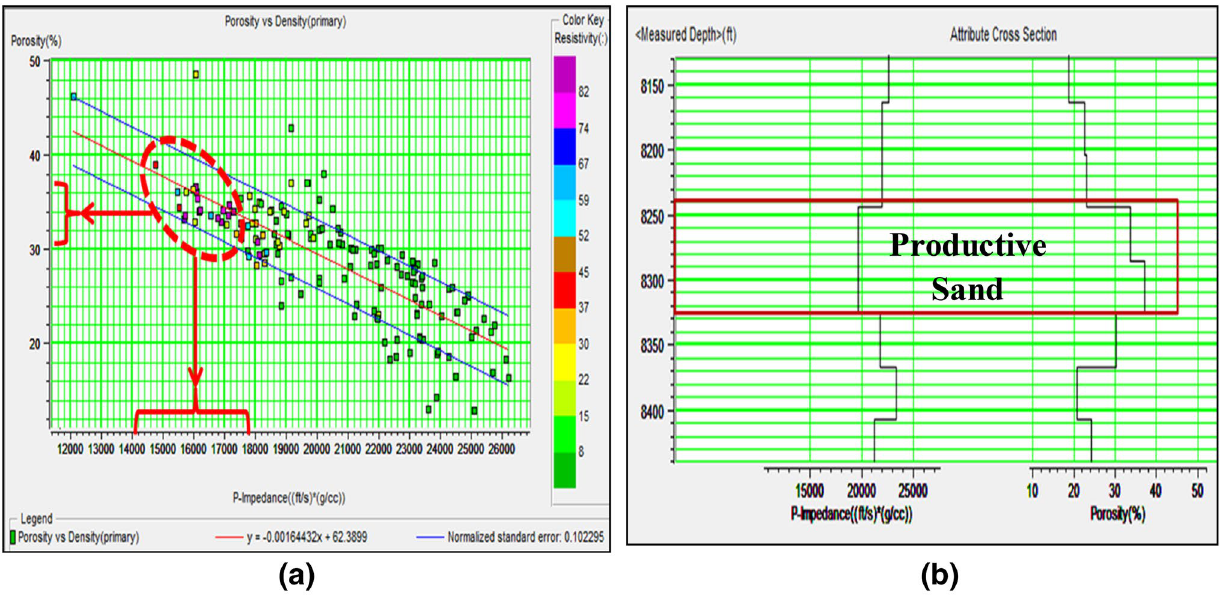
Fig. 8 a Crossplot of resistivity value in productive zone with acoustic impedance and porosity in reservoir R1, well 1. b Cross section relation- ship of AI and porosity at the productive zone (Reservoir